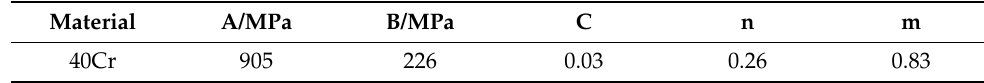
Table 2. 40Cr alloy steel J-C model